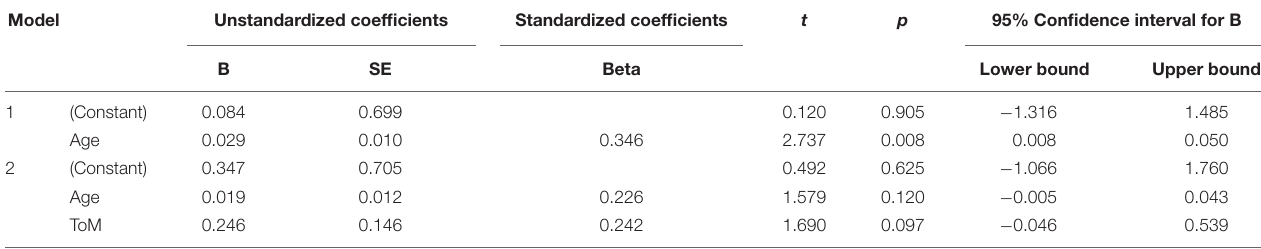
TABLE 5 | Hierarchical linear regression predicting intention judgment in study